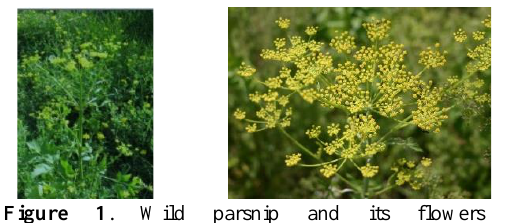
Figure 1 . Wild parsnip and its flowers